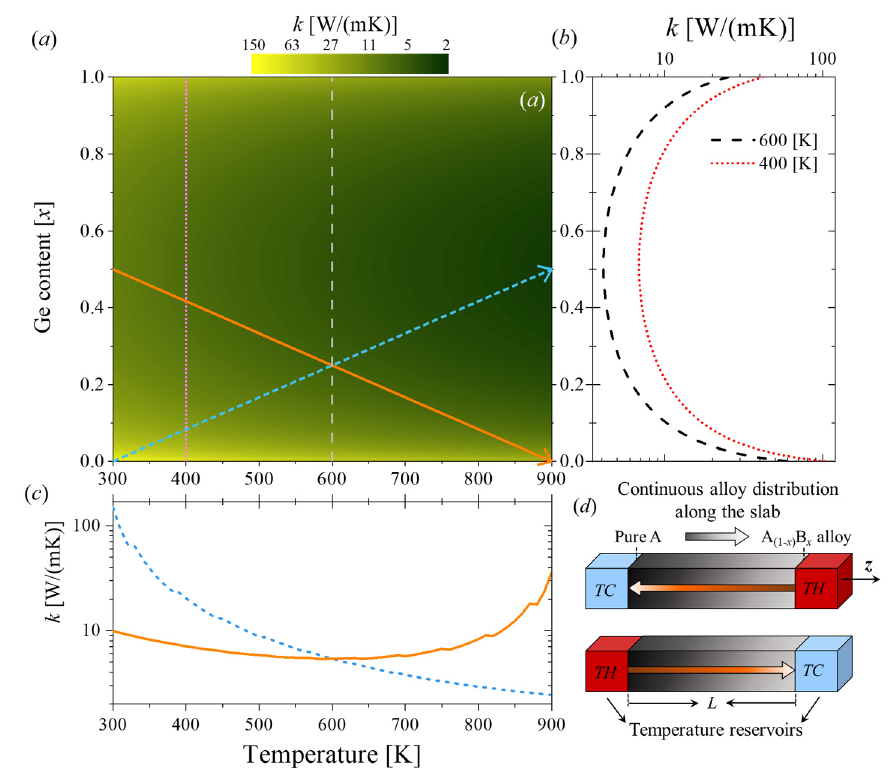
Figure 1. ( a ) Contour plot of the thermal conductivity ( k ) of Si (1 − x ) Ge x alloy as a function of Ge content ( x ) and temperature (green contour). Four different “cuts” of the contour taken, as indicated by the colored lines ( b ), two vertical cuts at T = 400 and 600 K (dotted magenta and dotted grey lines, respectively), and ( c ) two diagonal cuts (solid orange and dotted blue lines). ( b ) Thermal conduc- tivity of Si (1 − x ) Ge x as a function of Ge content at a fixed temperature T = 400 and 600 K (dotted red and dashed black lines, respectively). ( c ) Thermal conductivity as a function of temperature of a Si (1 − x ) Ge x slab where the Ge content varies linearly along the slab between x = 0 (pure silicon, Si) and x = 0.5 (Si 0.5 Ge 0.5 ). It should be noted that this spatial dependence creates different k curves when the temperature reservoirs are changed. ( d ) Schematic representation of the continuous alloy distribu- tion along the heat flux axis ( z ) of a hypothetical slab of alloy of length L for the cold-hot (forward) and hot-cold (reverse) configurations. Figure 2. ( a ) Spatial atomic distribution of B (or A) atoms along the A (1 − x ) B x alloy slab. ( b ) Schematic representation of the variation in the atomic content along the slab. The color scale represents the amount of A atoms in the A (1 − x ) B x alloy slab. The color bar is valid for all of the slabs for their respec- tive colors.